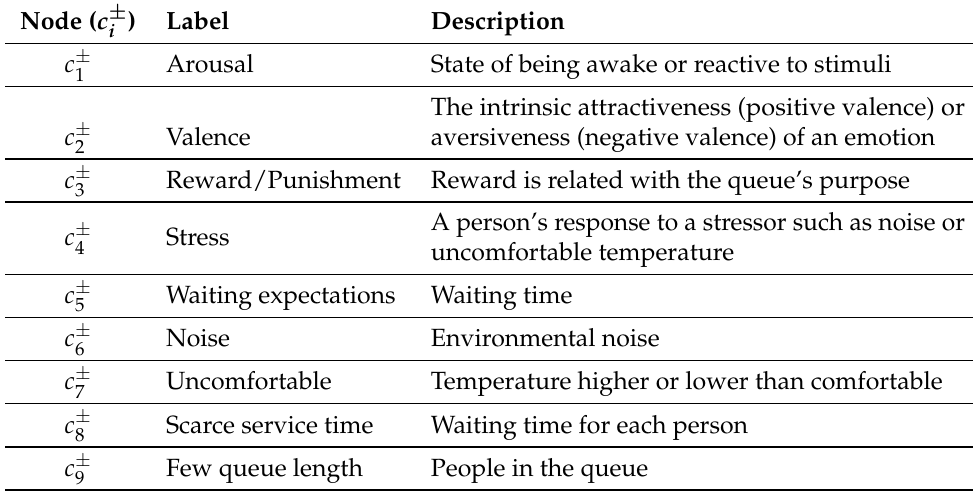
Table 1. FGCM nodes and description.